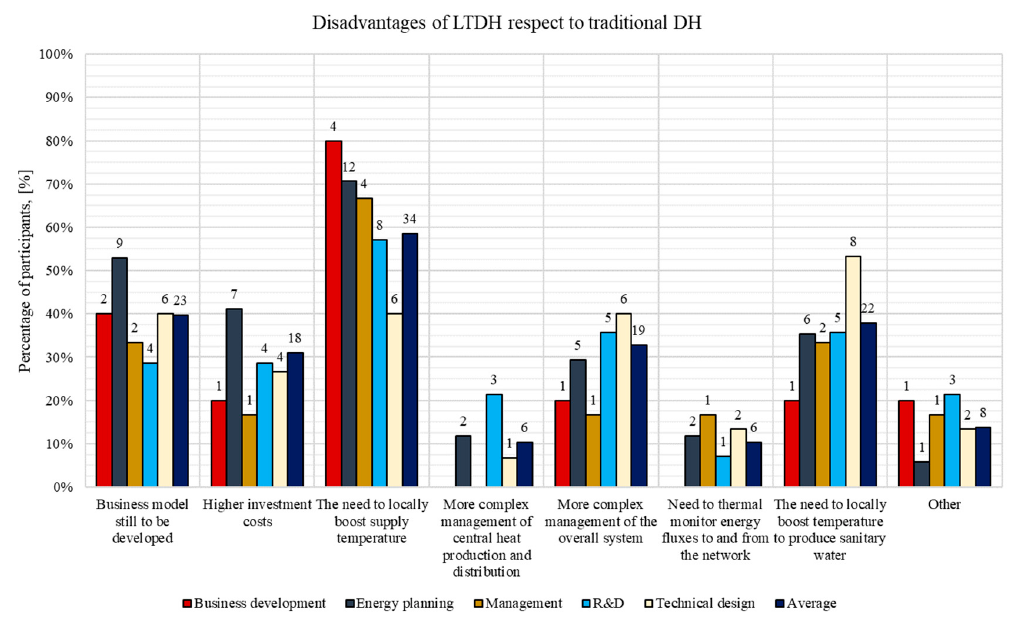
Figure 27. Disadvantages of LTDH systems with respect to traditional DH as a function of the employment role.